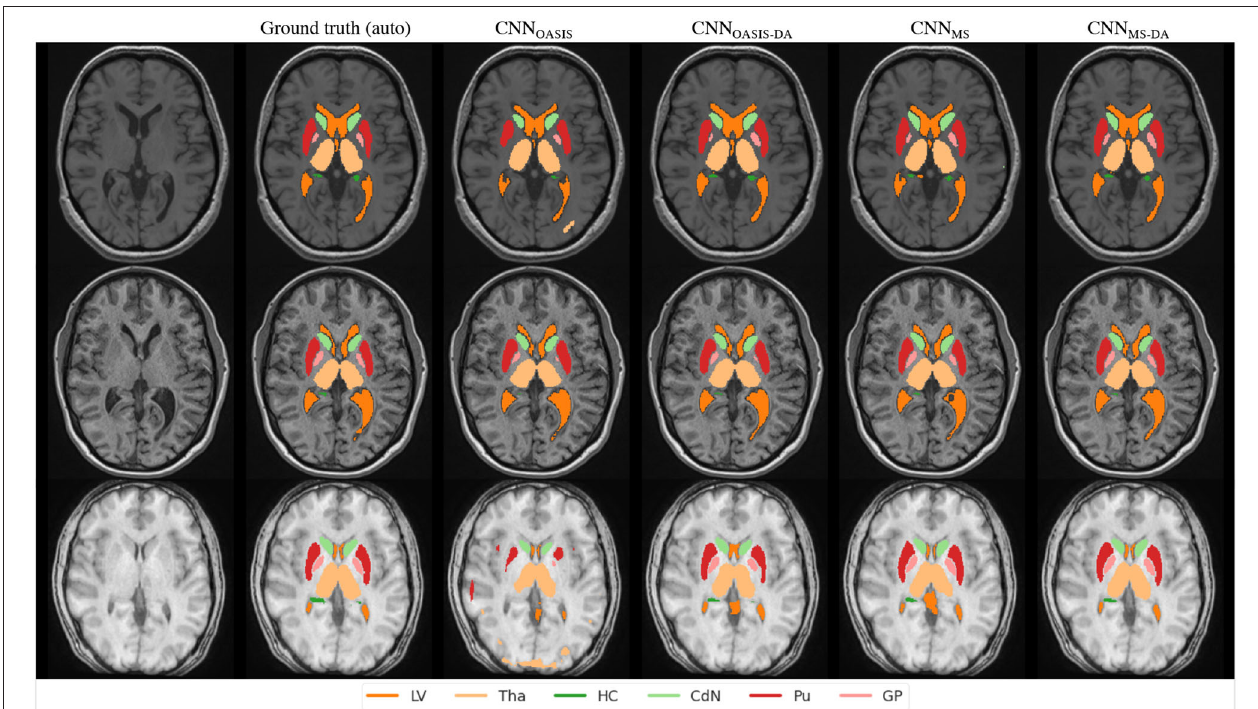
FIGURE 6 | Segmentation results for the different models on three test examples from the MS dataset. The automated ground truth is computed by ico brain . Results from CNN OASIS are very variable depending on image intensity. The addition of GMM-DA improves the segmentation